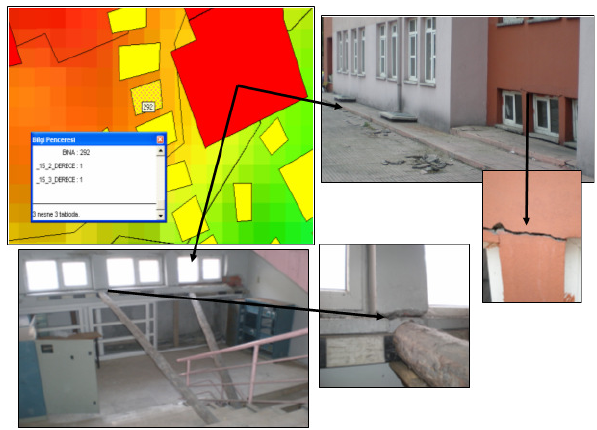
Figure 12. GIS integration process.